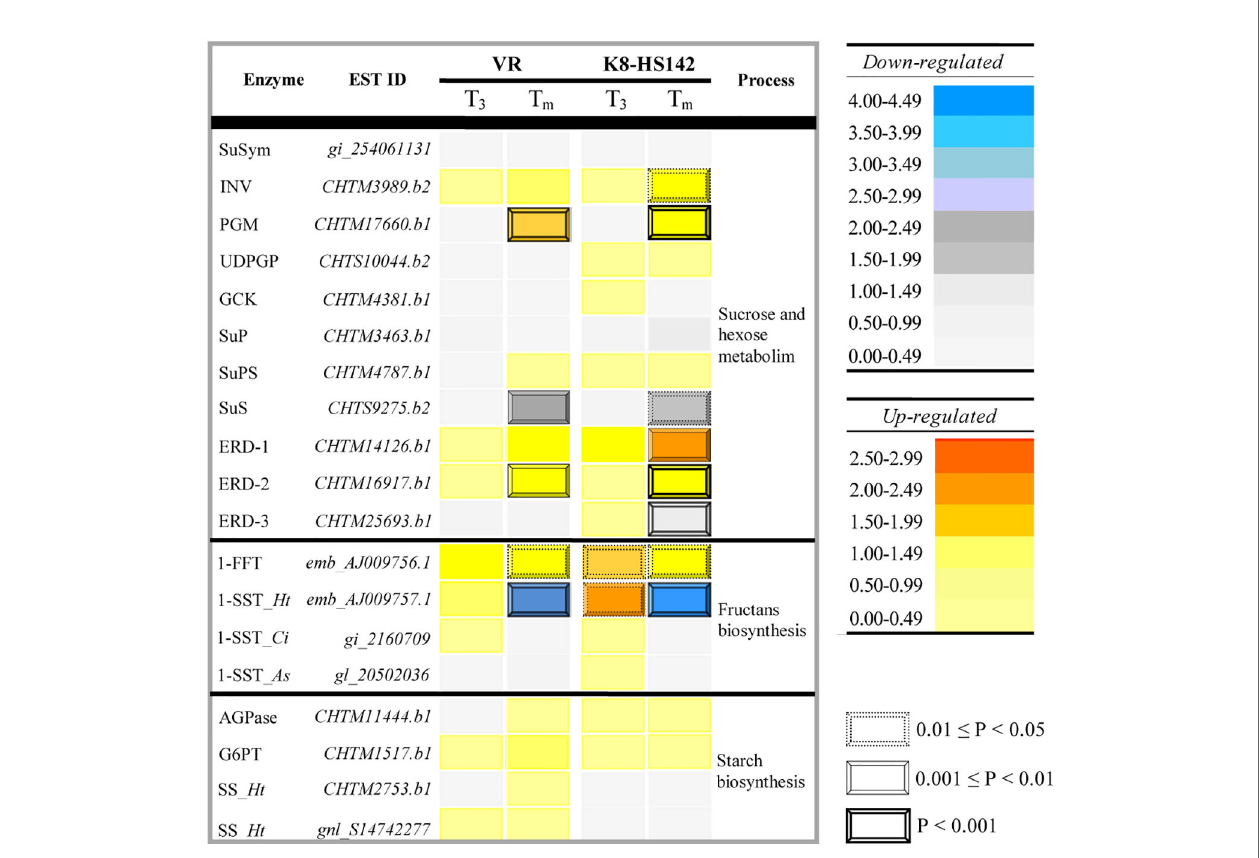
FIGURE 4 | Temporal expression of the expressed sequence tags (ESTs) involved in the metabolism of storage carbohydrates in Helianthus tuberosus “ VR ” and “ K8-HS142 ” clones. The relative emission levels of ESTs implied in the metabolism of sucrose, fructans, and starch at T 3 or T m compared to T 0 reference stage (when tuberization begins), both in “ VR ” and “ K8-HS142, ” are displayed through a heat map. Magnitudes and statistical relevance of each EST contest are in the map. The statistical signi fi cance of the differences were tested according to the LIMMA. Key to genes. Simple sugars metabolism. SuSym, Sucrose H + /symporter; SuP, Sucrose phosphatase; SuS, Sucrose synthase; INV, Neutral/alkaline invertase; GCK, Glucokinase; PGM, Phosphoglucomutase; UDPGP, UDP-glucose pyrosphorilase; ERD, Early Response to Dehydration 6 - H + /Glucose symporter . Fructan polymerization. 1-SST, Sucrose:sucrose 1-fructosyltransferase; 1-FFT, Fructan:fructan 1-fructosyltransferase. Starch metabolism and polymerization. G6PT, Glucose 6-phosphate translocator; SS, Starch synthase. Ht, Helianthus tuberosus; St, Solanum tuberosum; Ci, Chicorium intybus; As, Allium sativum